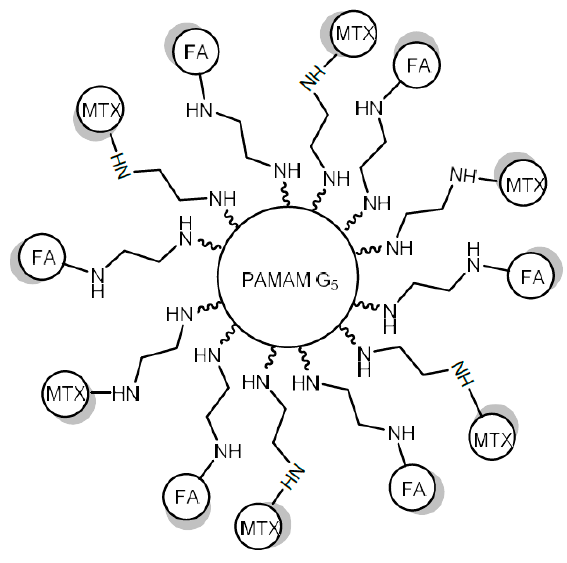
Figure 7. PAMAM G5 conjugated with FA and MTX [57].